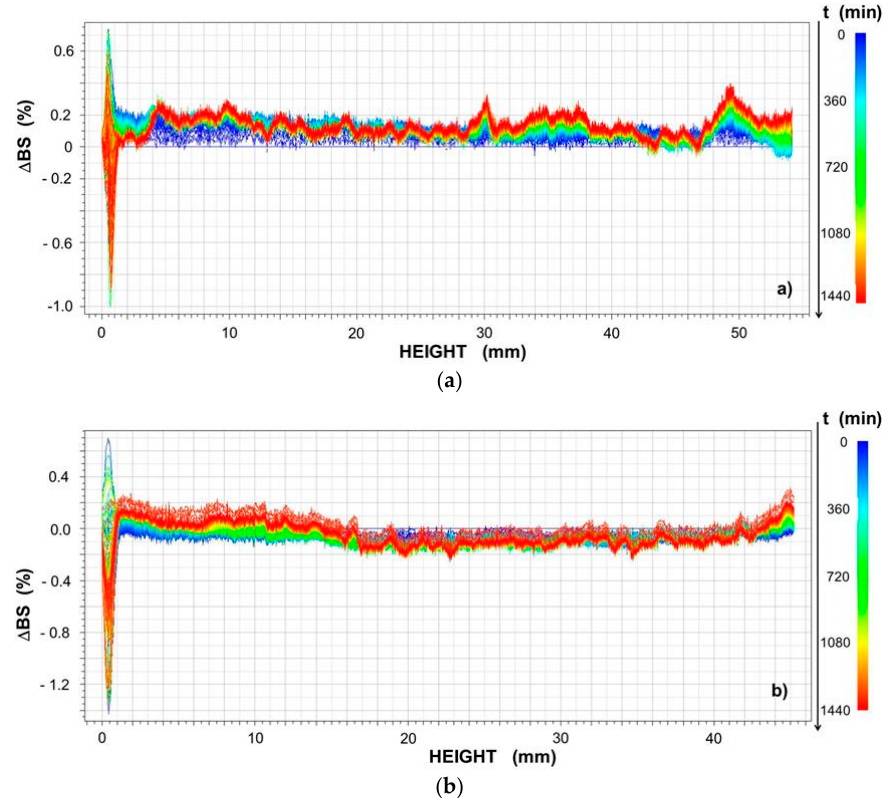
Figure 8. ( a ) ∆ BS of C2(1) sample; and ( b ) ∆ BS of C2(2) sample.